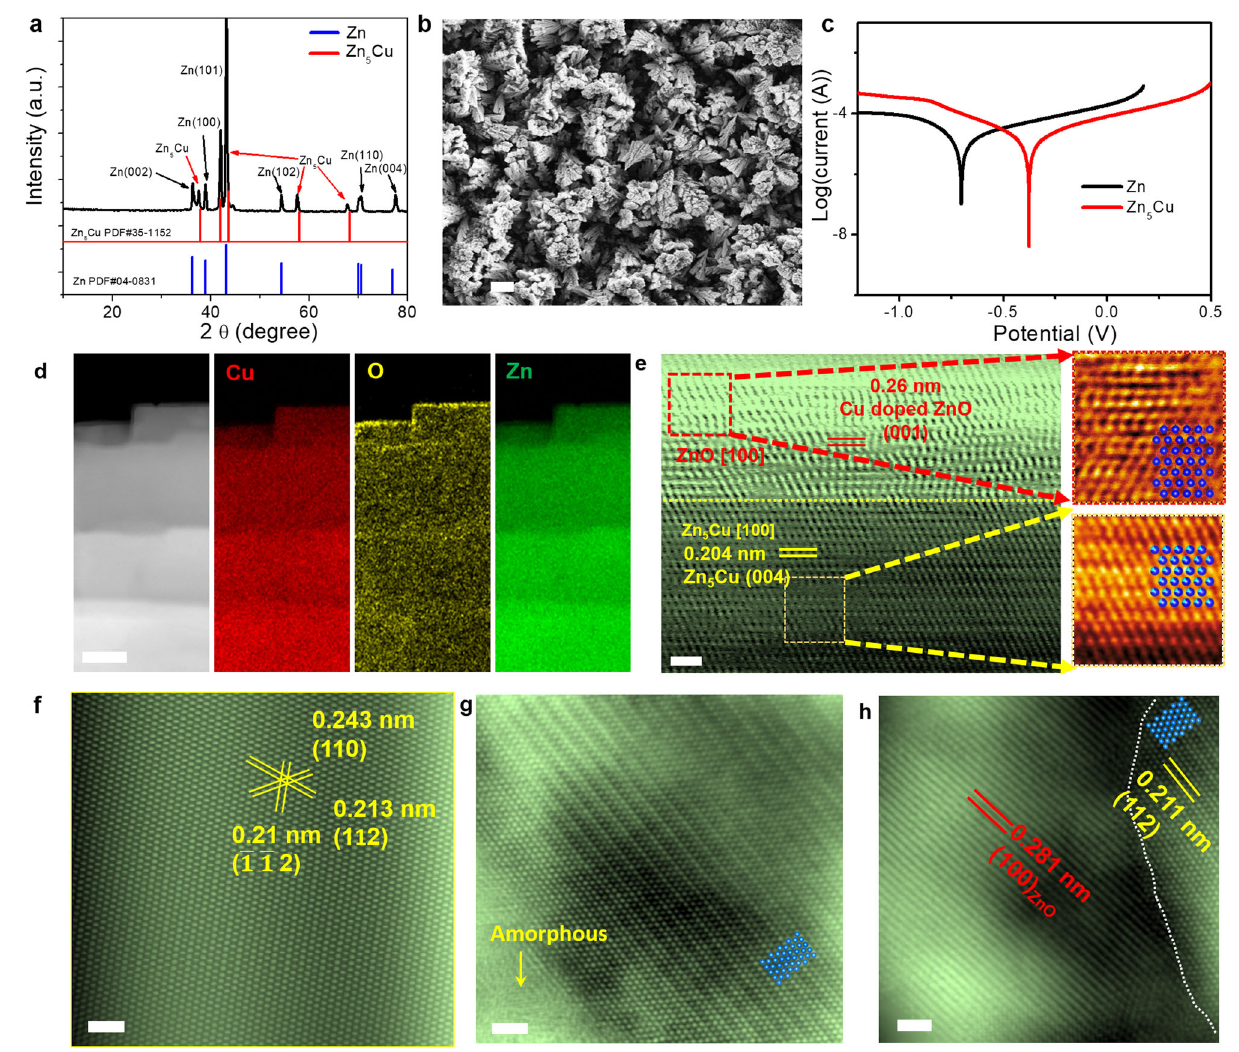
Fig.1|StructuralcharacterizationsofZn-Cuanode.a XRDpattern. b SEMimage of3DZn-Cuanodes.Scalebar:10.0 µ m. c TafelplotsofZnandZn-Cuanodes. d EDS- mapping of Zn 5 Cu. Scale bar: 50nm. e STEM image of the ZnO/Zn 5 Cu interface.